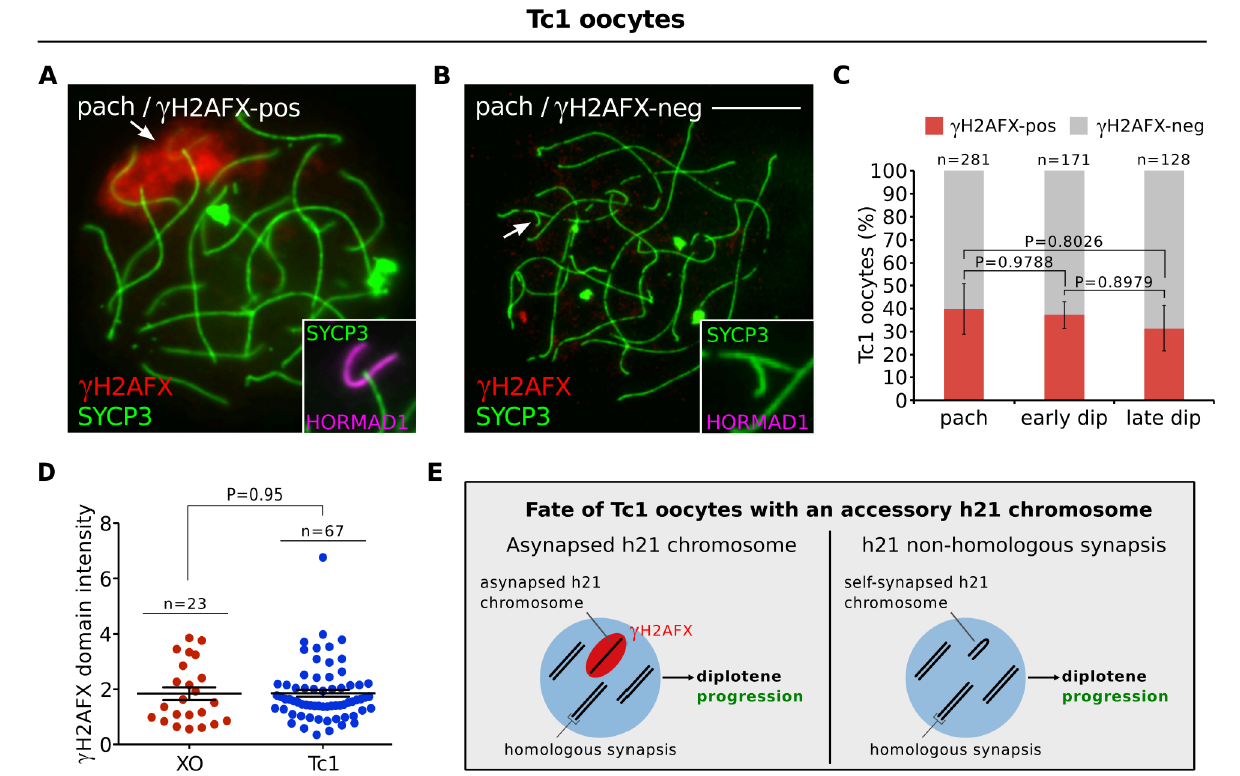
Fig 4. Oocytes in the Tc1 accessory chromosome mouse model do not exhibit diplotene elimination. ( A ) Pachytene Tc1 oocyte with an asynapsed h21 chromosome (arrow, inset), labelled with γ H2AFX (red, arrow) and HORMAD1 (magenta, inset). ( B ) Pachytene Tc1 oocyte with self-synapsed h21 chromosome (arrow, inset), which is negative for γ H2AFX and HORMAD1. Scale bar represents 10 μ m. ( C ) Mean percentage ( ± s.e.m.) of Tc1 oocytes with a γ H2AFX-positive or γ H2AFX-negative h21 chromosome between pachynema and late diplonema, demonstrating no significant elimination of Tc1 oocytes with asynapsed h21 chromosomes. n is the number of oocytes counted from three non-littermate mice at 18.5 d pc . ( D ) Comparison of γ H2AFX domain integrated intensity between XO and Tc1 oocytes at diplonema, the stage when oocyte losses are observed in XO but not Tc1 females. n refers to the number of oocytes analyzed. ( E ) Schematic showing that the asynapsed h21 chromosome does not trigger oocyte losses at diplonema.